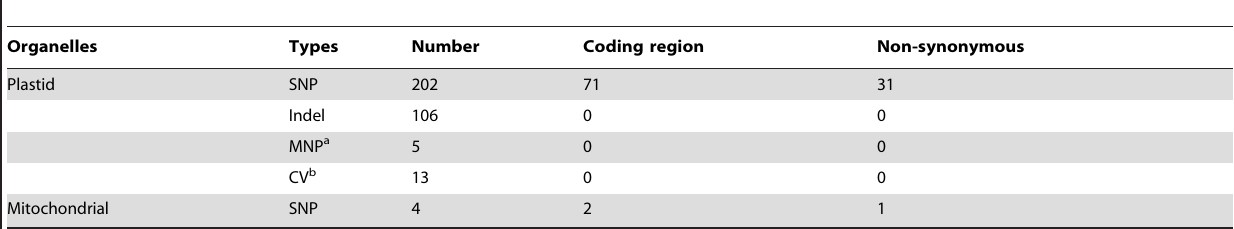
Table 8. Variations in plastid and mitochondrial